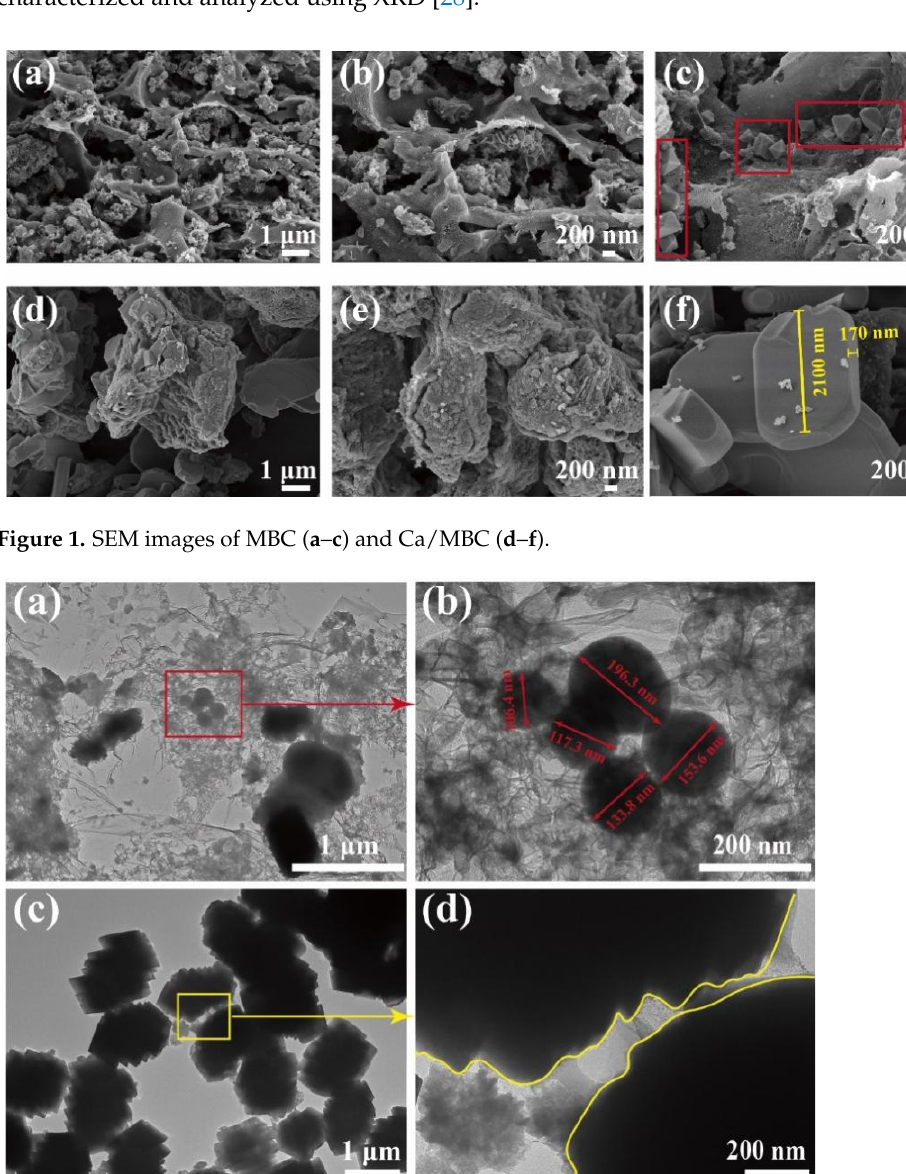
Figure 2. TEM images of MBC ( a , b ) and Ca/MBC ( c , d ).